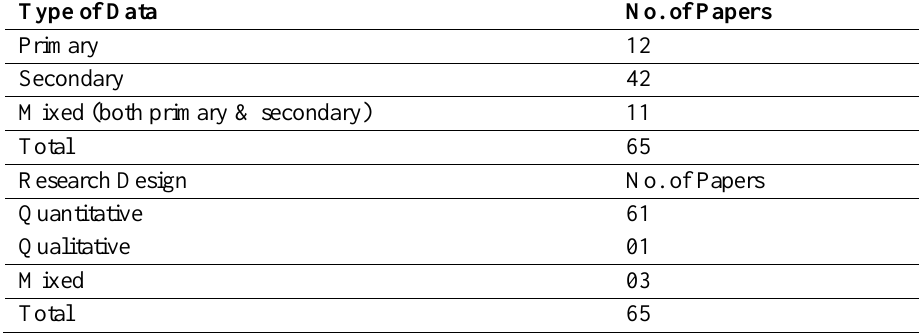
Table.2. Types of Data, Research Design & Unit of